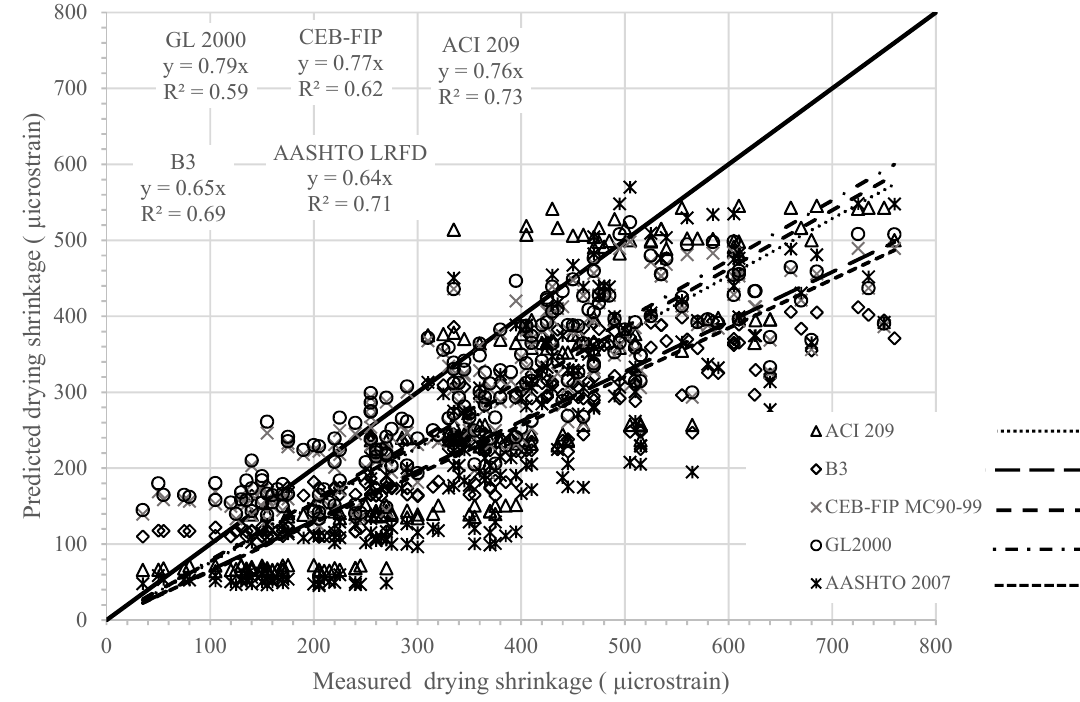
Figure 8. Comparison of measured and predicted drying shrinkage of SCC mixtures using different models. Table 11. Statistical analysis results of drying shrinkage predictions for SCC containing different types of SCM/filler.